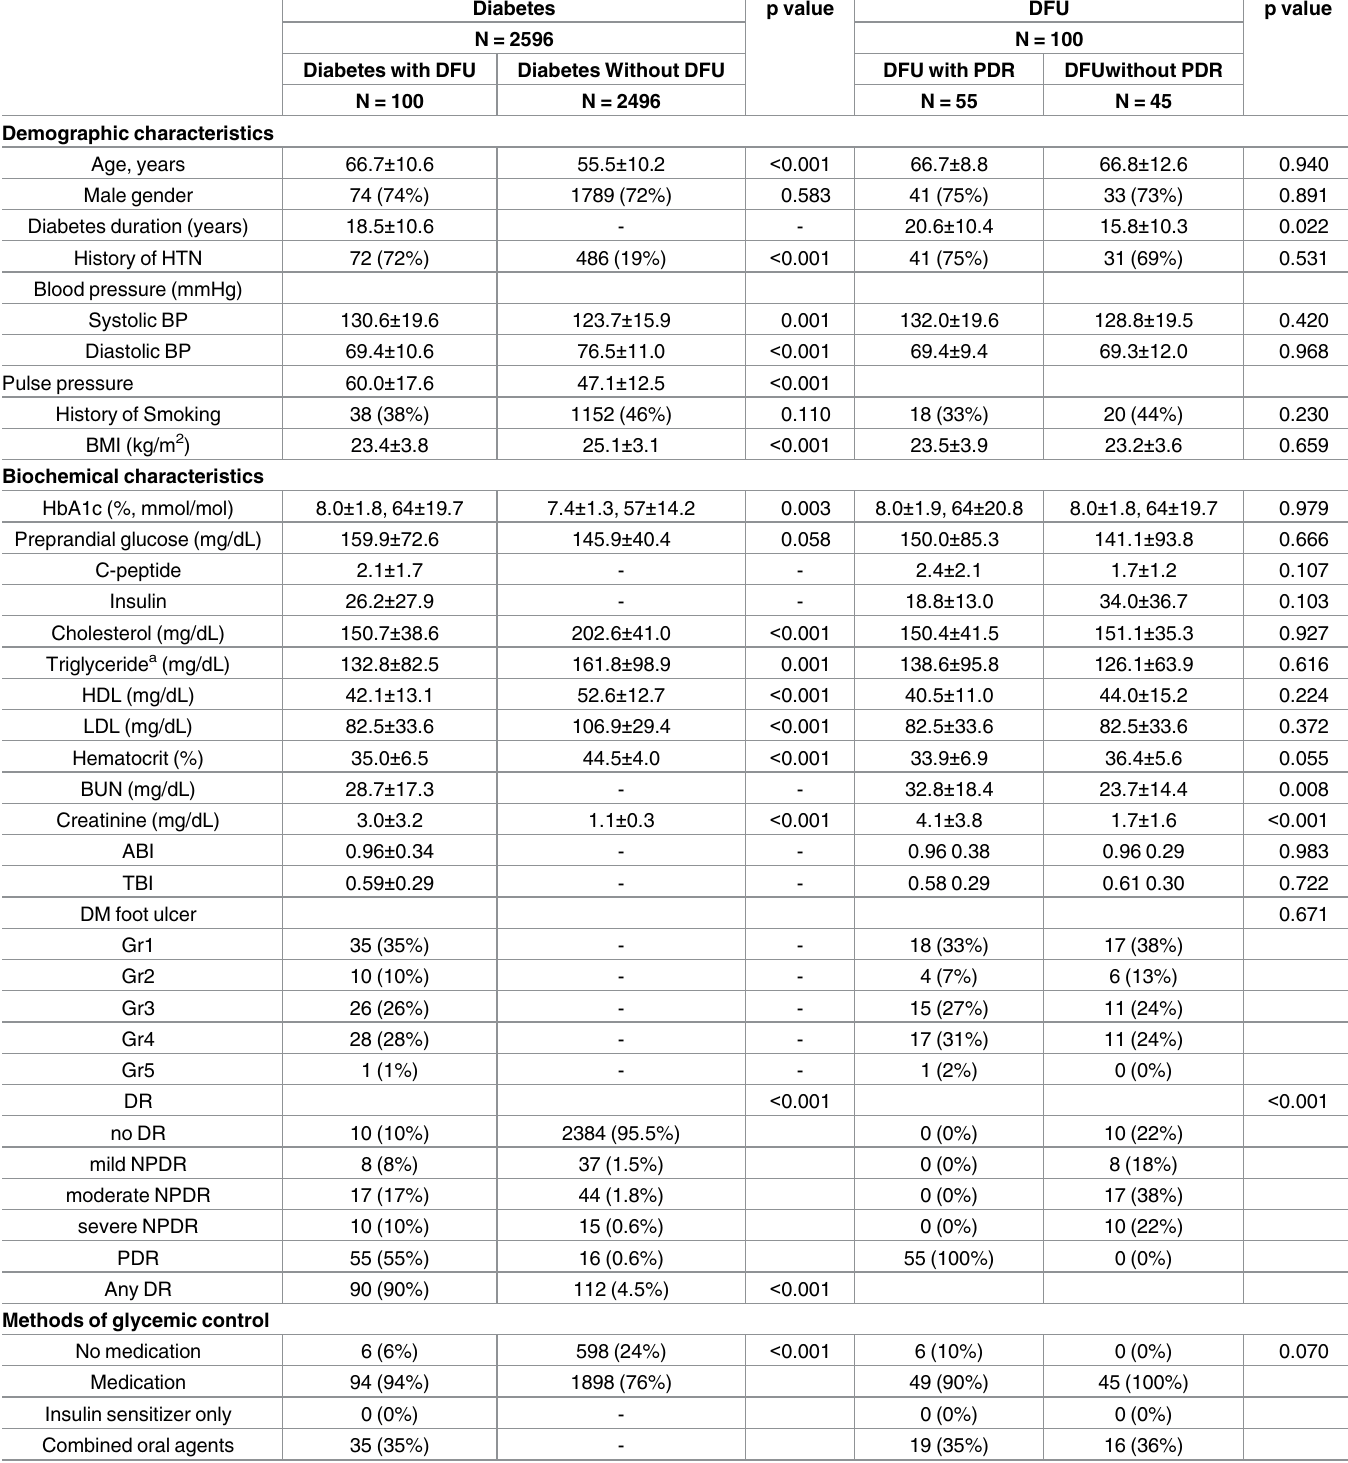
Table 1. Demographic, clinical, and laboratory characteristics of 100 type 2 diabetic patients with a diabetic foot ulcer (DFU) and 2496 type 2 dia- betic patients without a DFU.